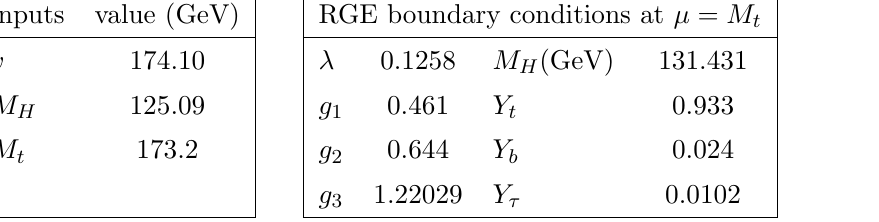
Table 2 . Values of the relevant SM parameters adopted in the numerical analysis, consistent